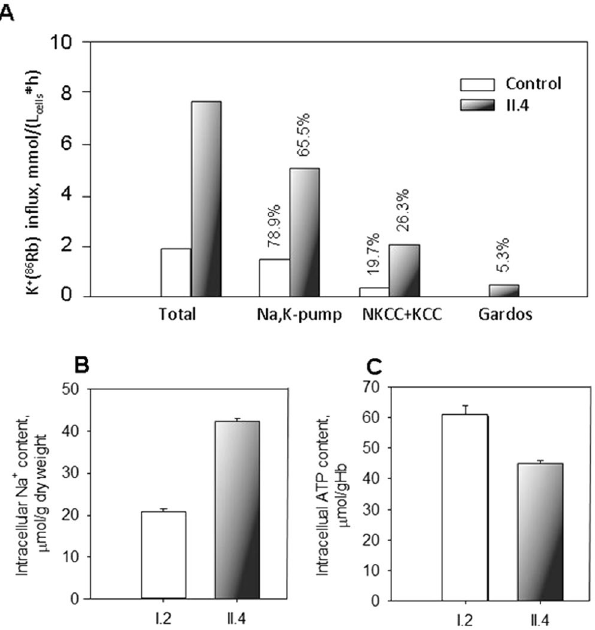
Figure 5. Activity of ion transporters, intracellular Na + and ATP content in circulating RBCs. ( A ) Unidirecitonal K + ( 86 Rb + ) influx into RBCs of a healthy control and patient II.4. Shown in the panel are bulk K + influx and the influx components carried by the Na,K-pump (ouabain-sensitive flux) and the fluxes mediated by the chloride-dependent influx mediated by Na,K,2Cl-, K,Cl-cotransporters, and Gardos channel activity (TRAM-34-sensitive flux). White bars show the flux values for RBCs of healthy control and black bars are for the fluxes in II.4 patient’s RBCs. Numbers above the bars indicate the contribution of each ion transporter into the total influx of either patient or healthy control in %. Intracellular Na + ( B ) and ATP ( C ) content of RBCs of the healthy I.2 (white bar) and patient II.4 (black bar) measured in triplicates on one occasion. Data are mean ± SD. Although statistical analysis could not be performed for single experiments all the values show clear difference between the I.2 and II.4 (for intracellular Na + and ATP levels) as well between the RBCs of II.4 and identically treated healthy control for all the K + ( 86 Rb + ) flux